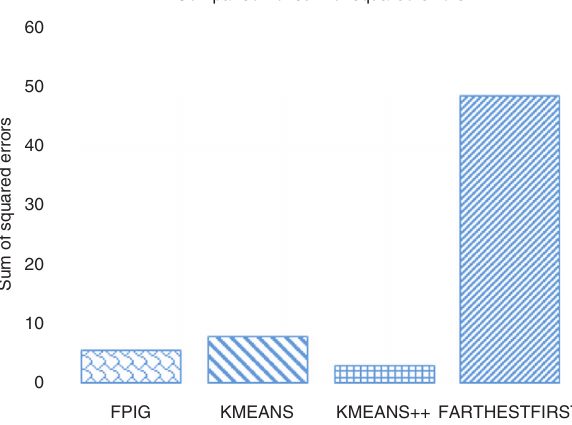
Figure 4: Sum of Squared Errors Between the FPIG and the Traditional Methods. Table 5: Statistical Values of Examined Methods.